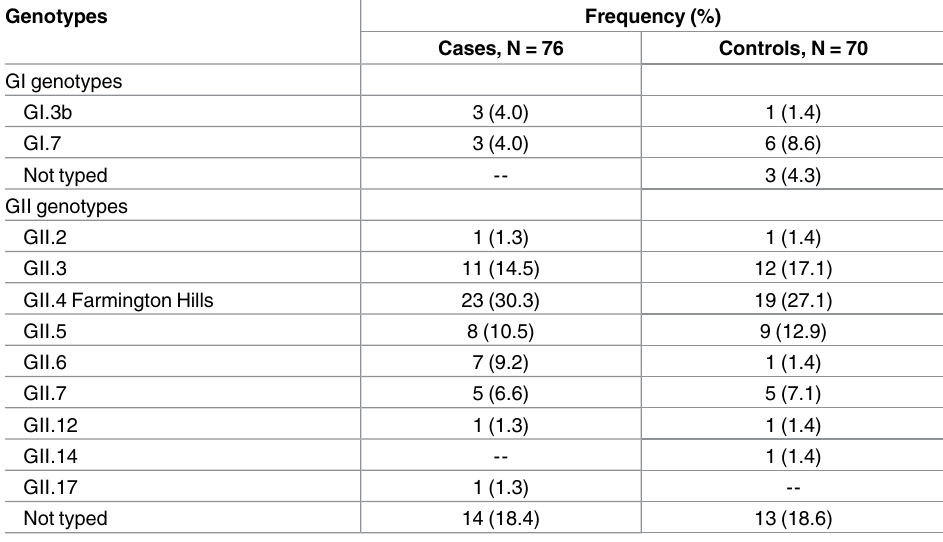
Table 3. Norovirus genotype distribution among cases and healthy controls. Genotypes